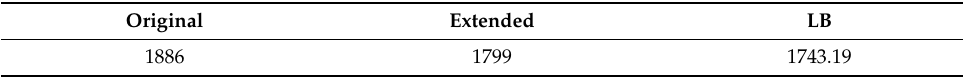
Table 11. Maximum makespan results (s) by proposal. Original